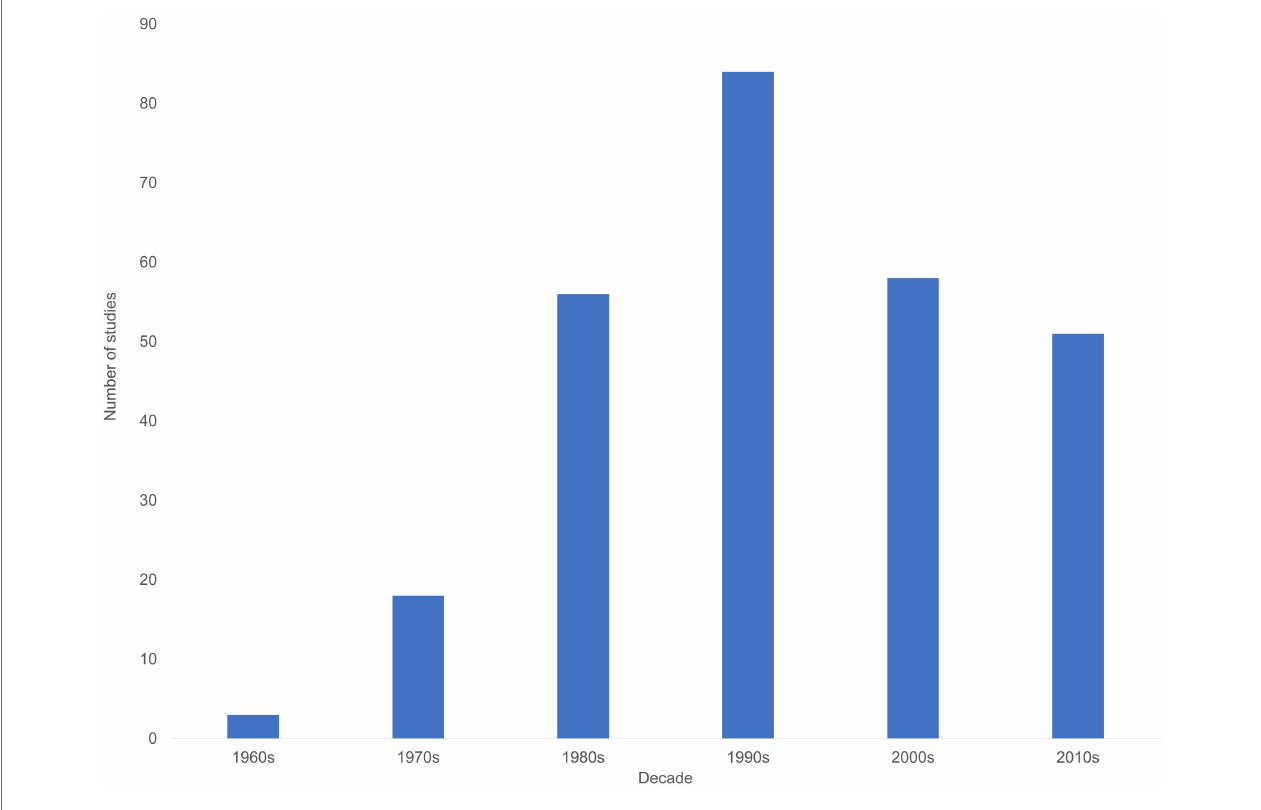
FIGURE 1 | Number of studies on minority influence per